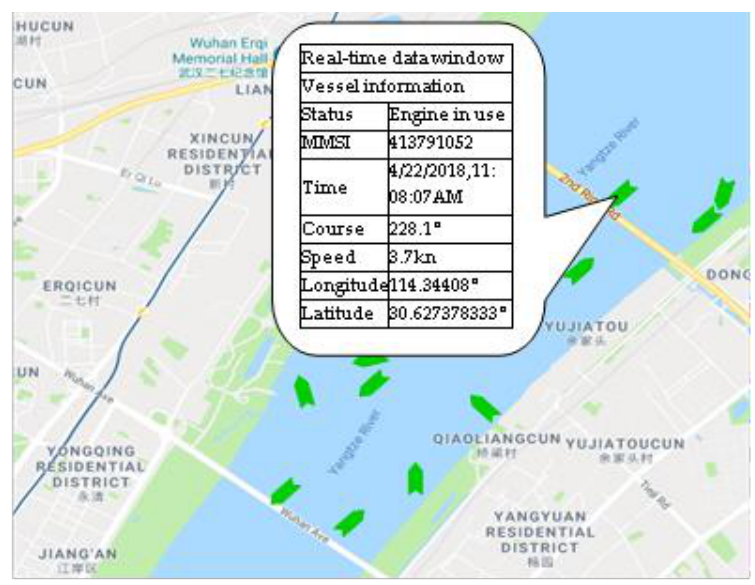
Figure 9. The AIS dynamic information displayed on the map.